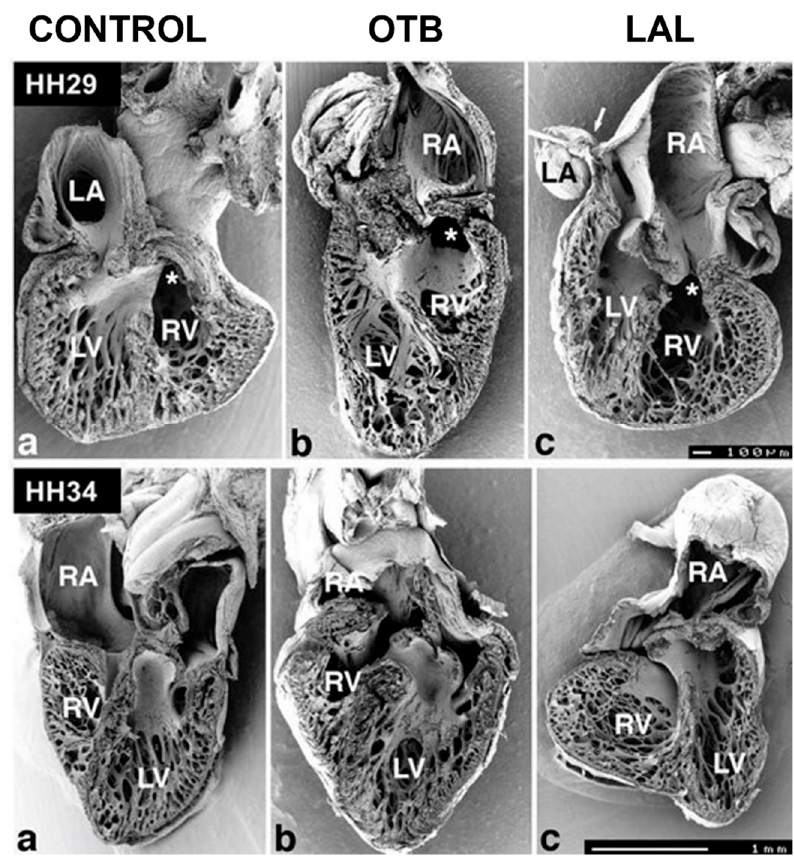
Figure 10. Scanning electron microscopy images of developing chicken hearts. The pictures show halves of frontally dissected hearts at HH29 ( top, ventral halves ) and HH34 ( bottom, dorsal halves ). For both stages, control and hemodynamically intervened hearts are shown. ( a ) Control hearts; ( b ) conotruncal banded hearts (OTB); ( c ) left atrial ligation (LAL) hearts. Top (HH29): Compared to the control heart, the OTB heart is more elongated with spiraling trabeculae, while the LAL heart exhibits closer packed trabeculae. Stars marks the entry of the conotruncus. Scale bar = 100 µm. Bottom (HH34): Compared to the control heart, the atria of the OTB and LAL hearts are distorted, and ventricular proportions changed. Trabecular structures also show a distinct architecture. Scale bar 1 mm. RA: right atrium; LA: left atrium; RV: right ventricle; LV: left ventricle. Reproduced with permission from [71].